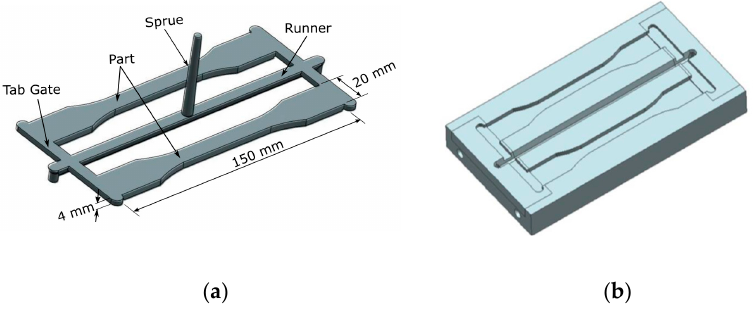
Figure 5. Mold inserts designed for the thick flat part: ( a ) part design; ( b ) core insert design.